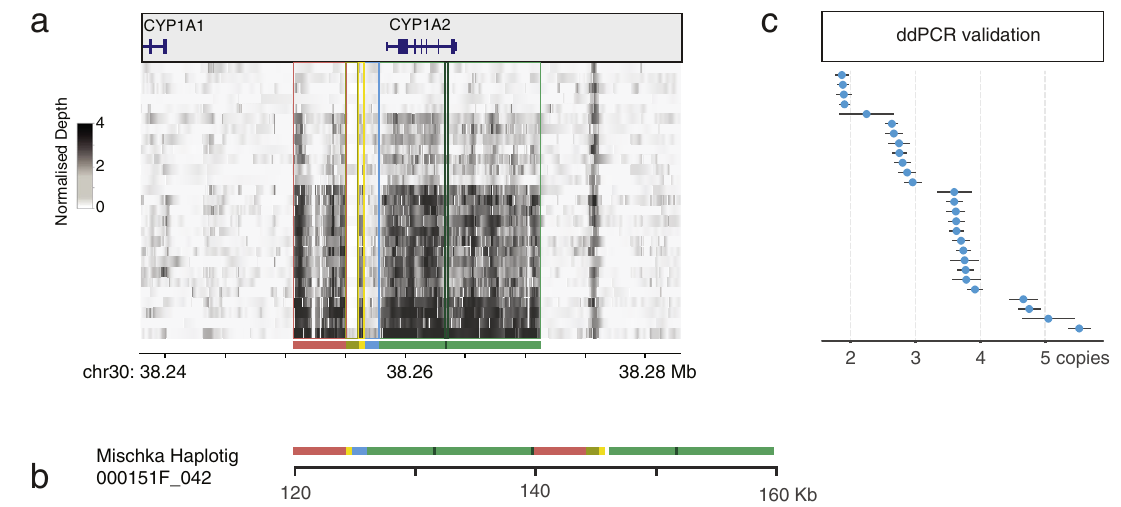
Fig. 5 Copy number expansion encompassing CYP1A2. a A duplication identi fi ed on chr 30 consists of six segments and contains the CYP1A2 gene. b The individual pieces from the reference are plotted as they appear in the alternative haplotig sequence (000151F_042) for Mischka (CNV = 3). Sequence was extracted from the FALCON assembly. Full-length CYP1A2 sits within copies of the green fragment. c The duplication was validated in the 10x sequenced individuals using